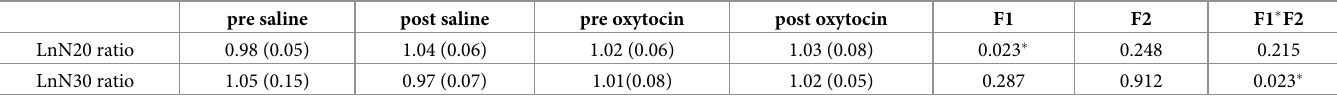
Table 1. Sensory evoked fields after saline or oxytocin administration during action observation.